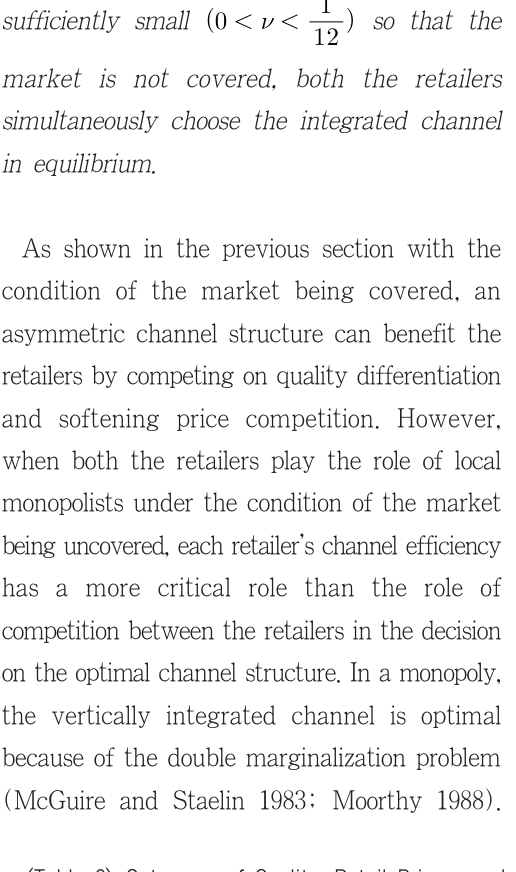
<Table 2> Outcomes of Quality, Retail Prices, and Retailers’ Profits under the Three Distribution Channel Structures in the Simultaneous-Channel-Choice Model  (when the market is not covered,     